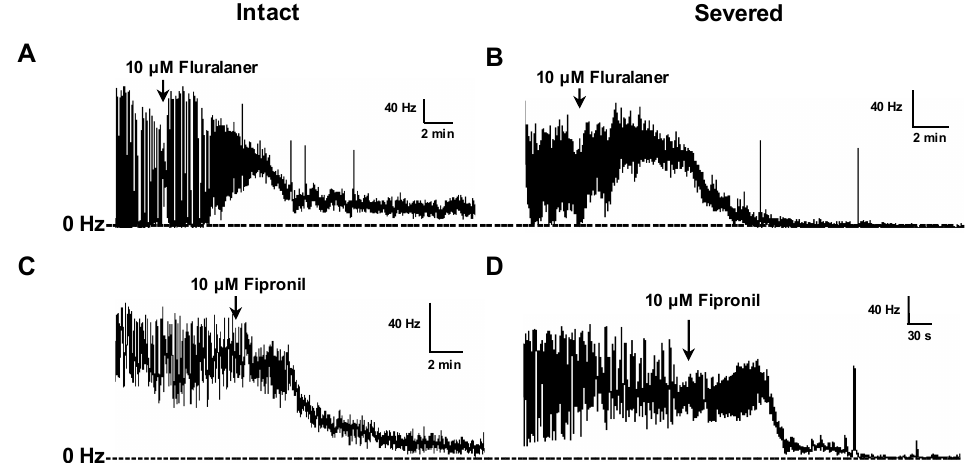
Figure 5. Electrophysiological recordings on intact or severed CS-OR D. melanogaster larval CNS. ( A ) Intact CNS treated with 10 µ M fluralaner; ( B ) Severed CNS treated with 10 µ M fluralaner; ( C ) Intact CNS treated with 10 µ M fipronil; ( D ) Severed CNS treated with 10 µ M fipronil.